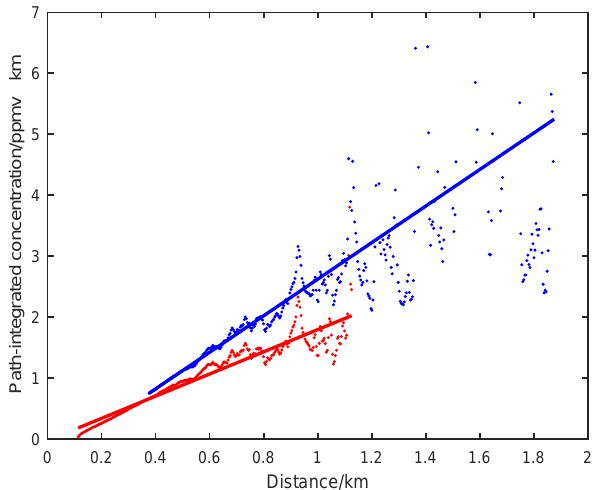
Figure 9. In red, the results of the two-step LLS approach applied to the data with indices m low to m hgh : the path-integrated concen- tration data calculated using α 0 and β 0 , and the linear least-squares straight-line fit to that data (cf. Fig. 2). In blue, the results of the GLS approach applied to the data with indices m e to m HGH : the data are calculated in terms of estimates of α and β , and the straight- line model in terms of estimates of A and B .